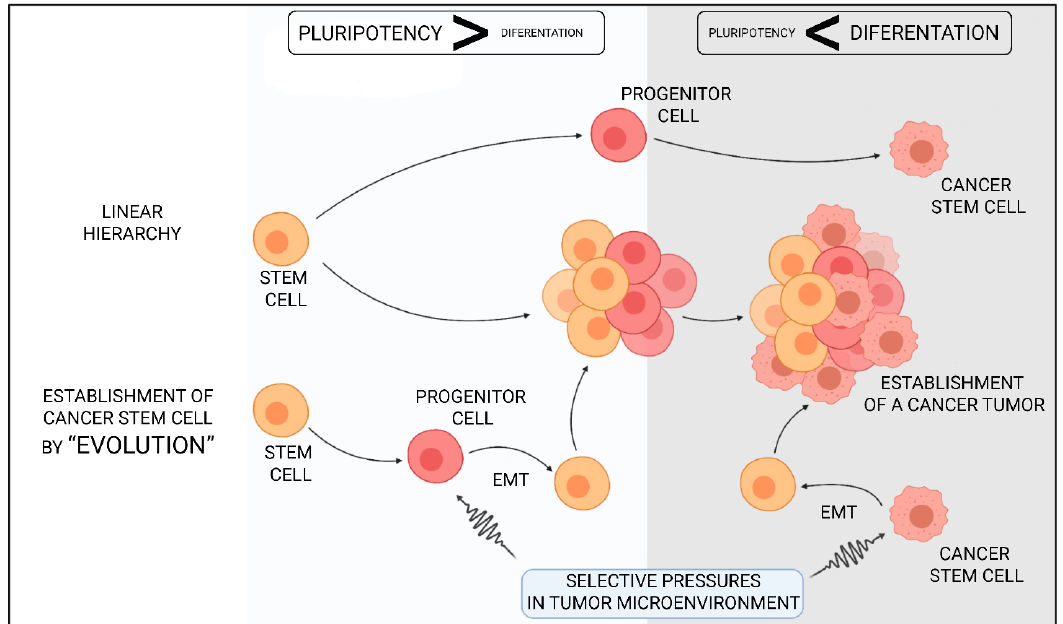
Figure 5. Two basic theories on the formation of cancer stem cells. In the theory assuming a hierarchical model of CSC formation, it is genetic and epigenetic transformation that leads to the formation of progenitor cells and cancer stem cells. The cells processed in this way undergo further transformations, which ultimately lead to the development of a tumour. Another theory, assuming the “evolution” of cancer stem cells, assumes that the whole process begins by induction of EMT, either as an element of the development of the disease or as a result of the activity of selected signals coming from the microenvironment of the tumour. Epithelial-to-Mesenchymal transition (EMT) is a natural process that triggers the development of the tumour, it determines changes in cell polarity and cell-cell